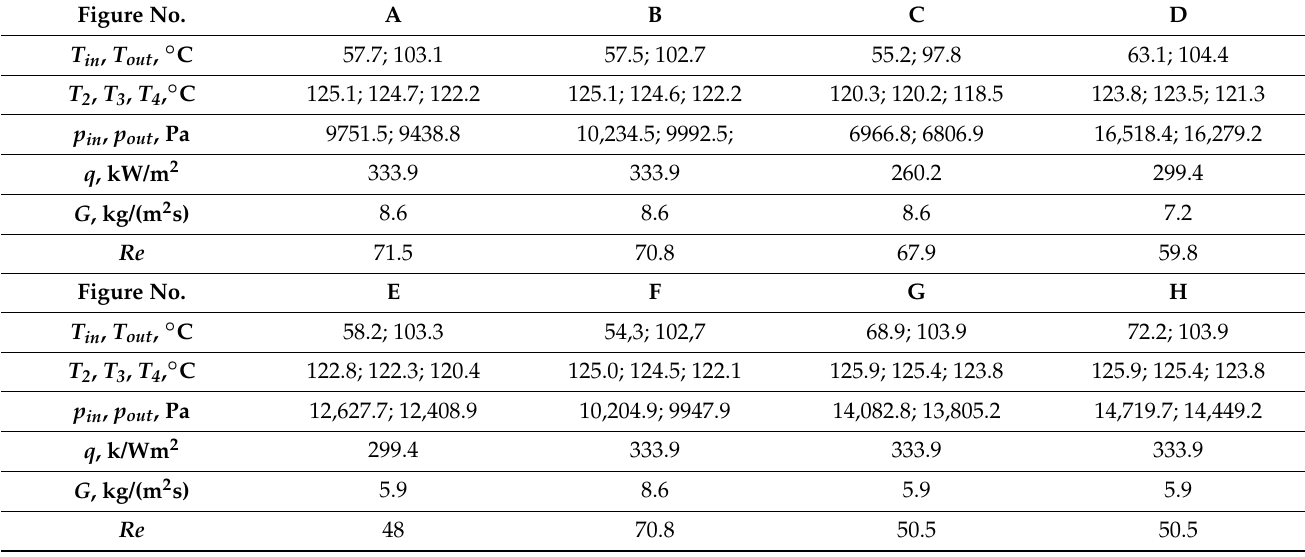
Table 5. Thermal-flow parameters for sample structures recorded during the experiment with water, Figure 10. Figure